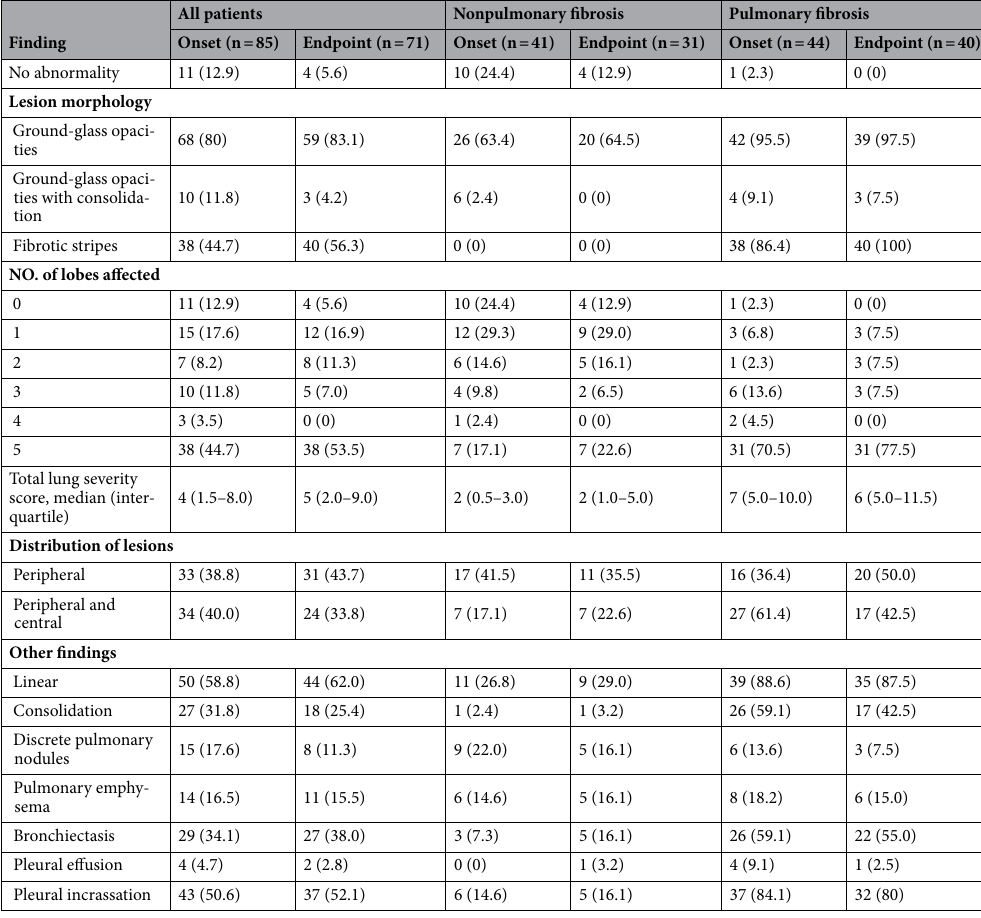
Table 2. Chest CT findings of patients with Covid-19. Except where indicated, data are cases of patients, with percentages in